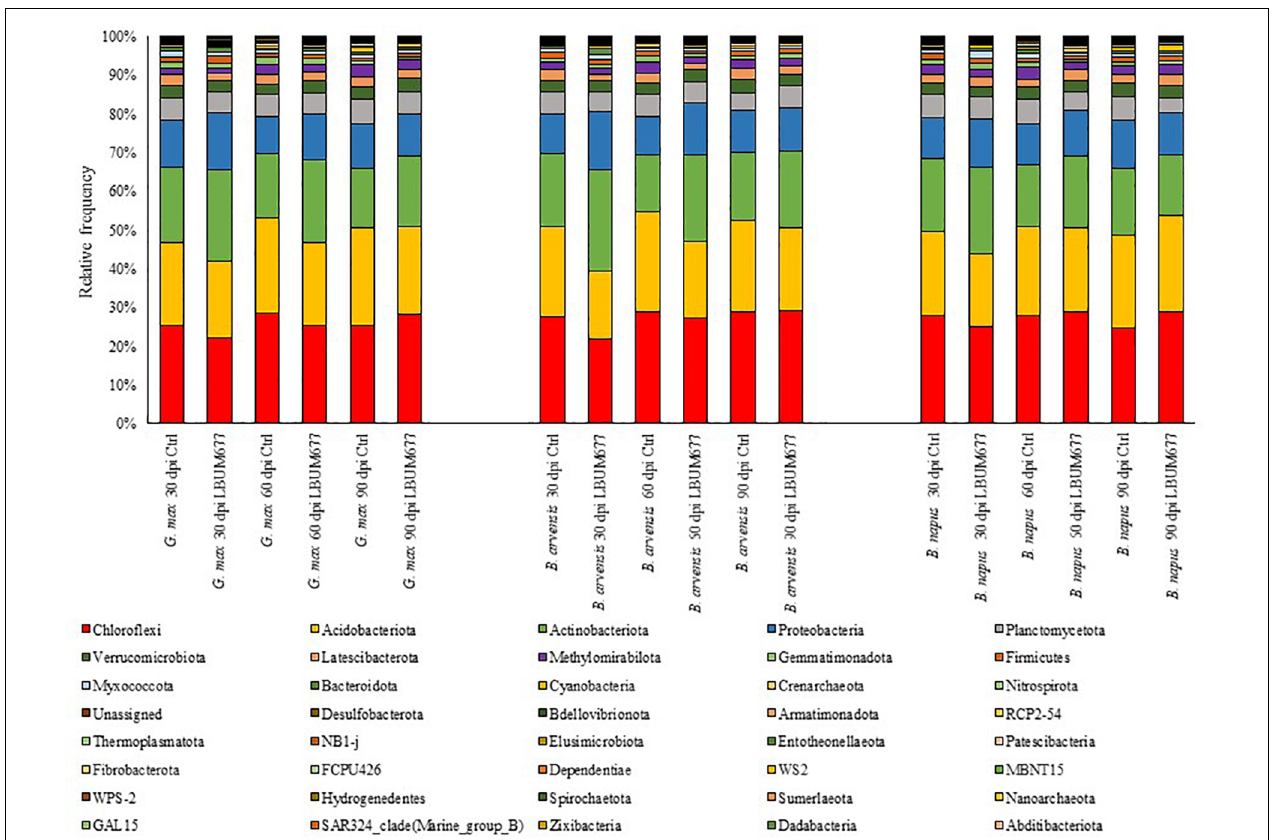
FIGURE 1 | Bar plot of the relative abundance of the bacterial taxa at the class level for each plant, date, and treatment combination under study.